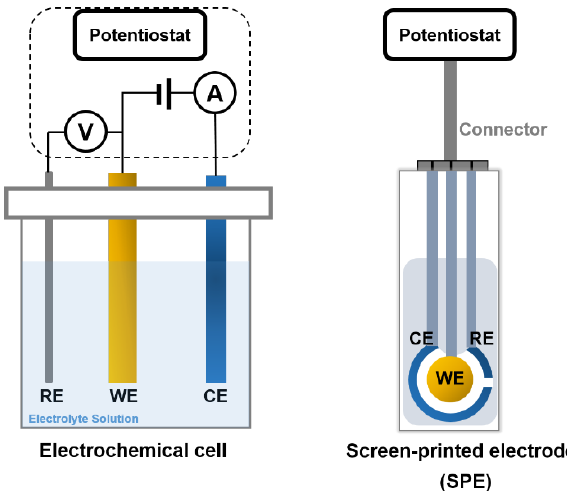
Figure 5. The two types of electrochemical biosensors with three electrodes: reference (RE), working (WE), and counter (CE) connected to a potentiostat.